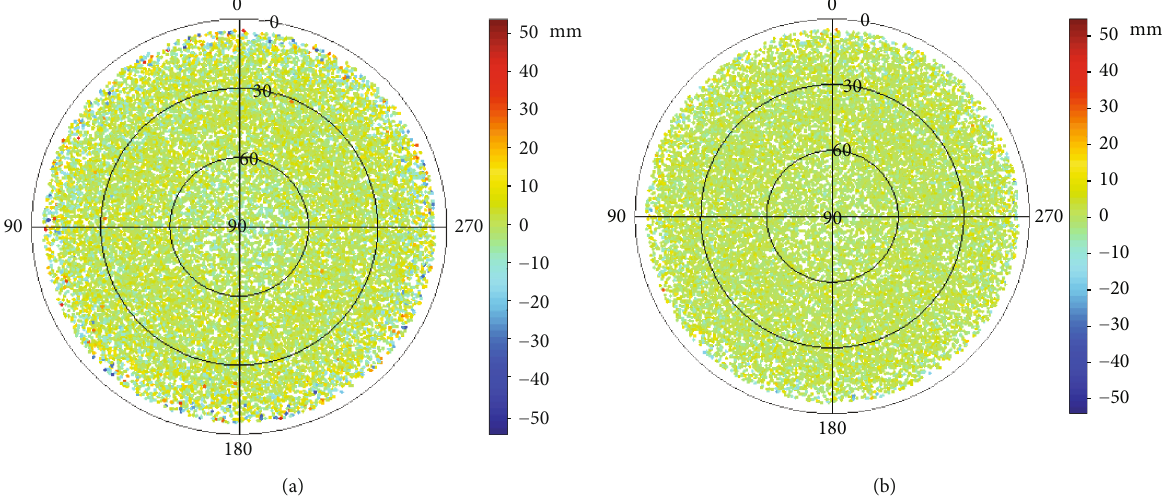
Figure 9: Measurement residuals for (a) KOMPSAT-5 and (b) GRACE-A on 14 July